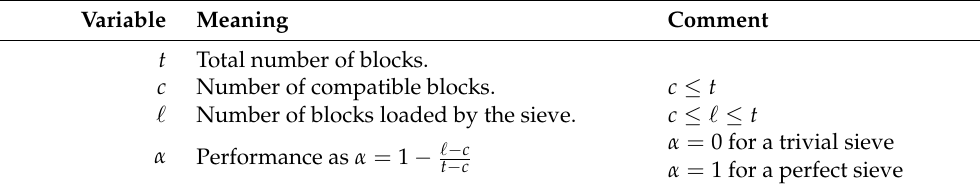
Table 3. Variables used to describe the performance of a sieve. The values t , c and (cid:96) are considered over a complete run of the solver for a given instance, e.g., summed over various values for the target width k